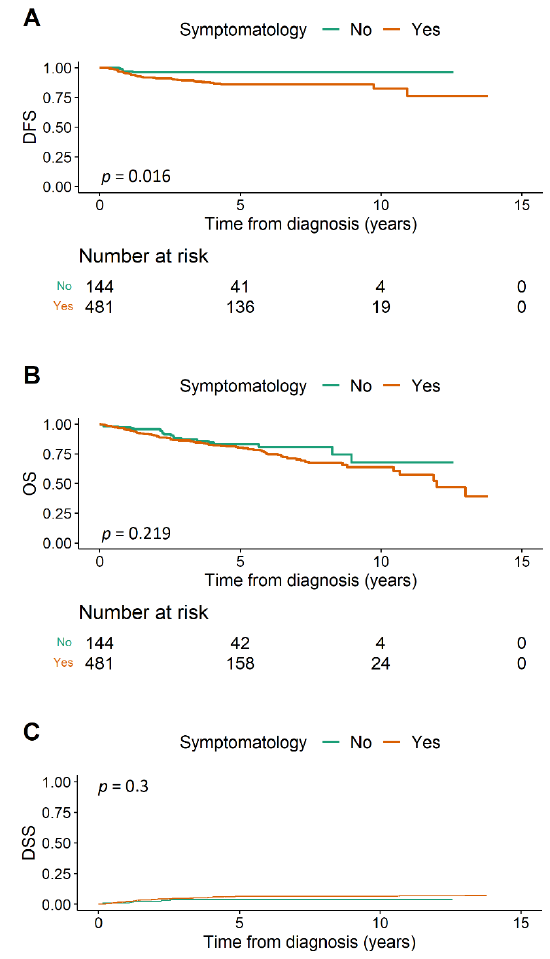
Figure 1. ( A ) Disease-free survival, ( B ) overall survival, ( C ) disease-specific survival. DFS = disease- free survival, OS = overall survival, DSS = disease-specific survival . Table 2. Disease-free survival — univariable and multivariable Cox proportional hazards model .